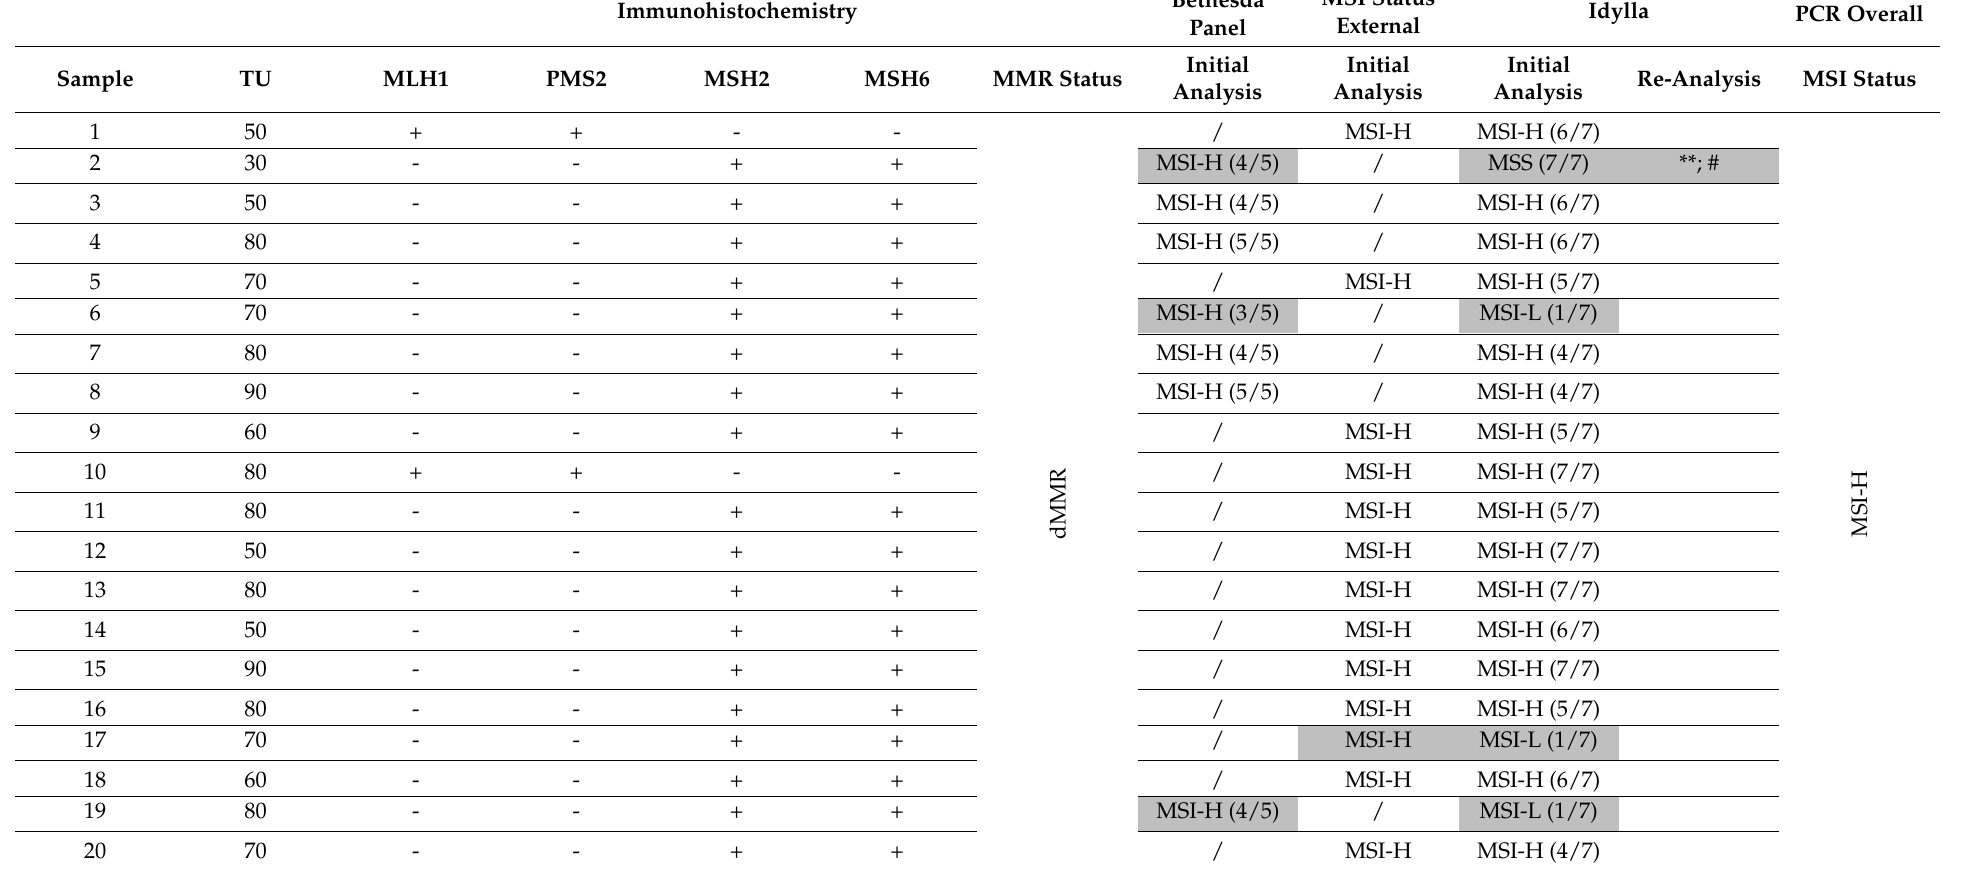
Table 3. Overview of mismatch repair (MMR) and microsatellite instability (MSI) status of cohort two after initial testing including immunohistochemistry, an in-house Bethesda panel, the MSI status estimated by another institute and the MSI status using the Idylla system, as well as reanalysis of microsatellite instability-high (MSI-H) samples resulting in microsatellite stable (MSS) via the Idylla